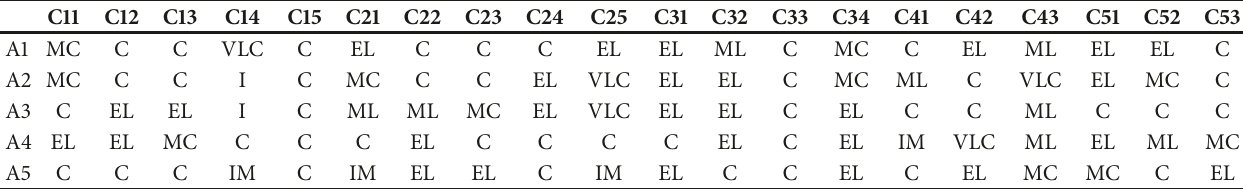
Table 7: Alternative evaluation of collective direct matrix [20].